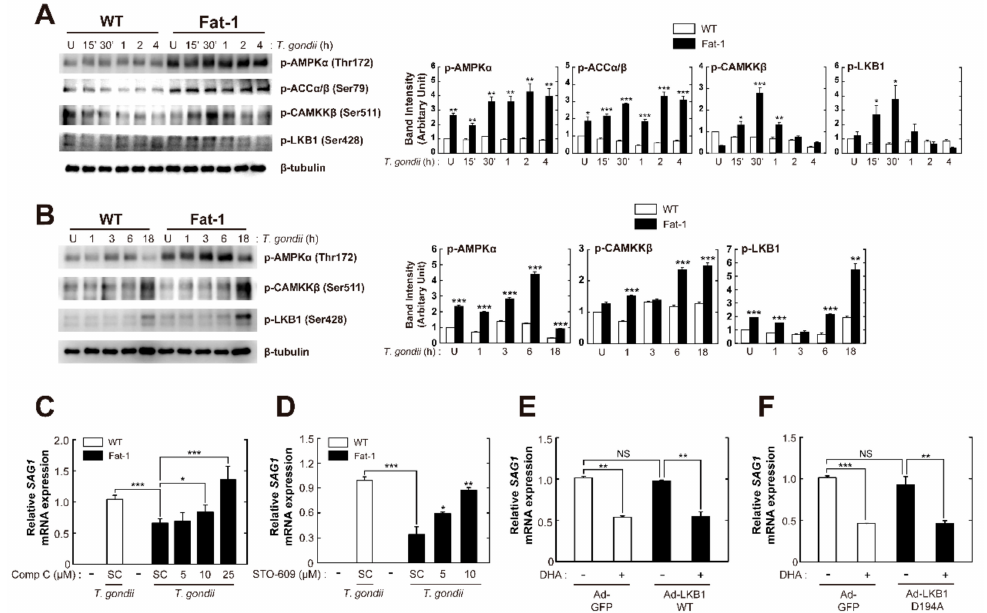
Figure 5. CaMKK β / AMPK activation plays an essential role in endogenous ω -3